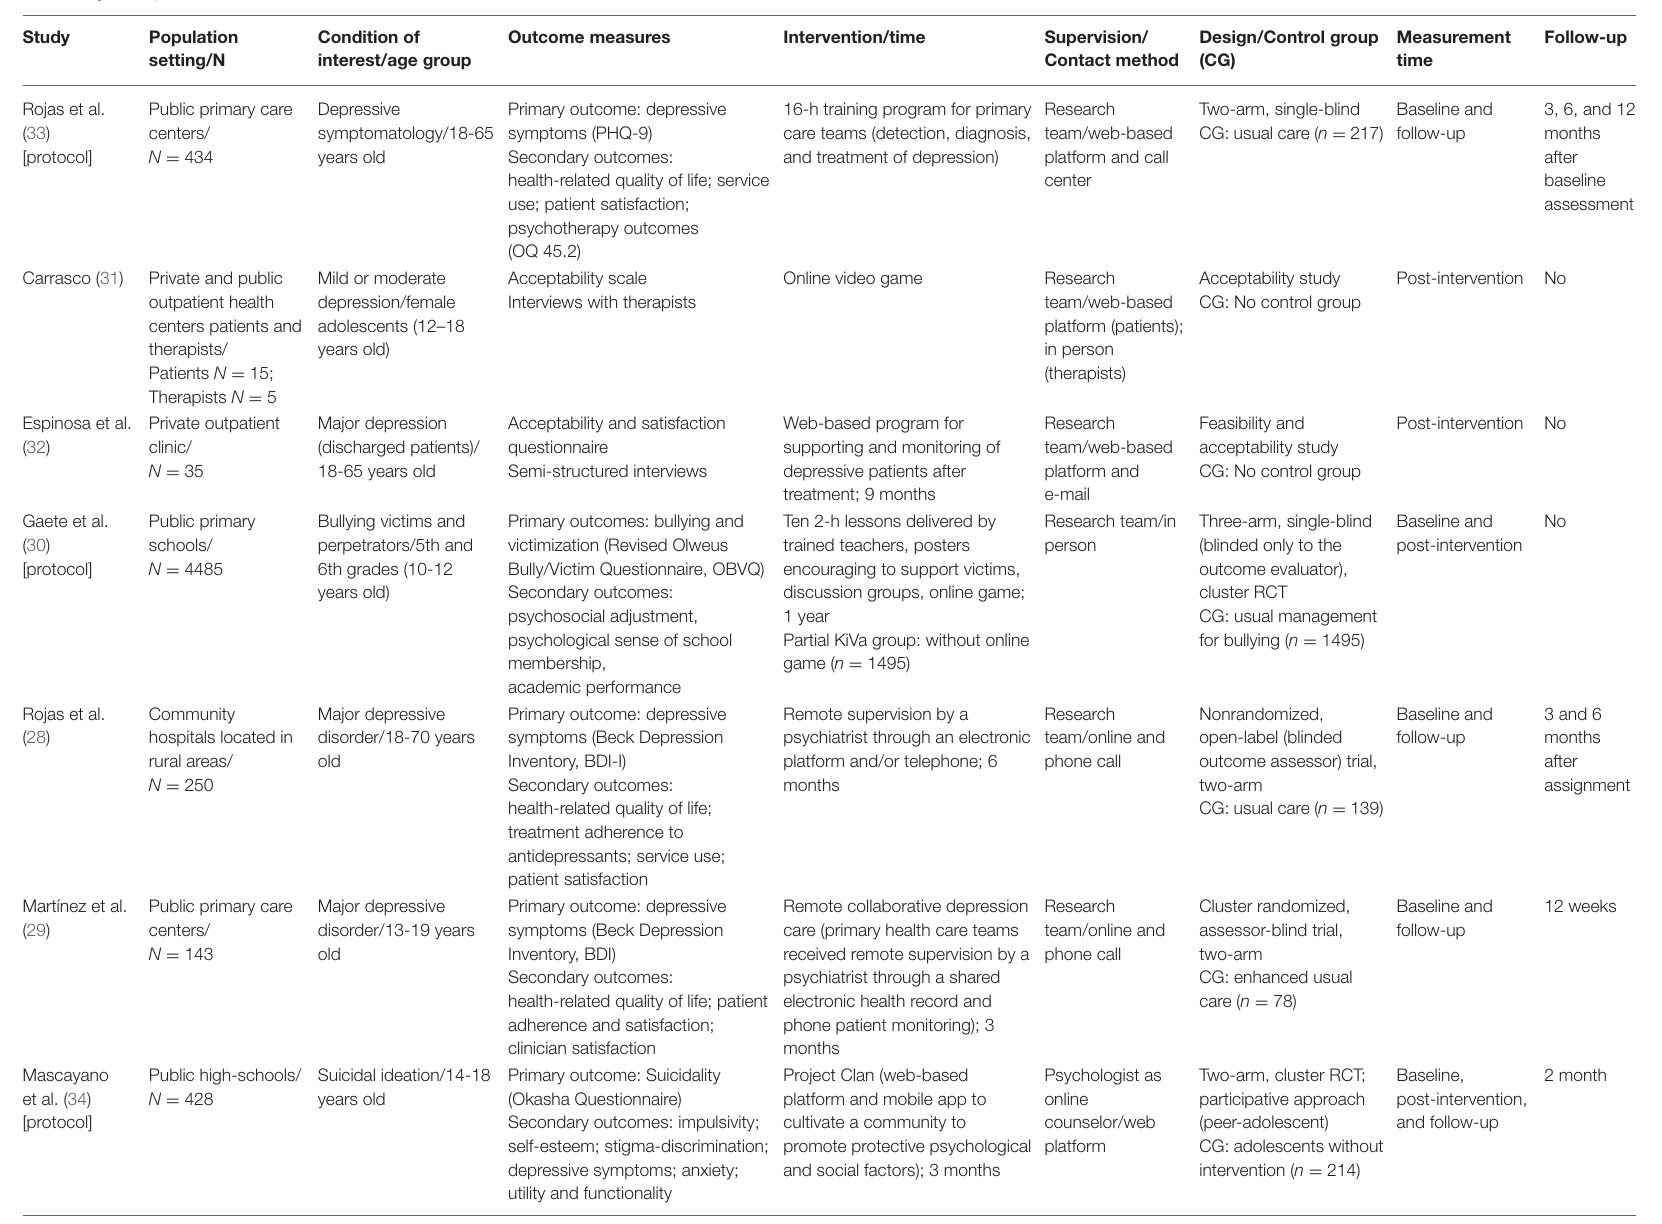
TABLE 1 | Description of